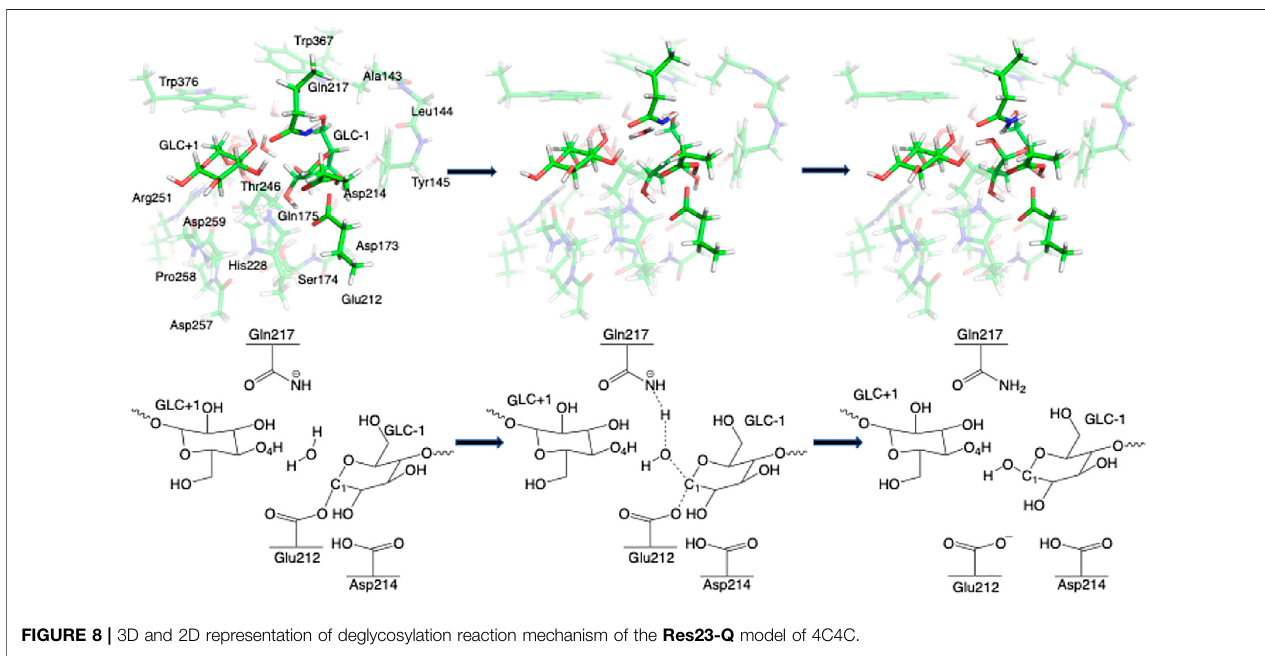
FIGURE 8 | 3D and 2D representation of deglycosylation reaction mechanism of the Res23-Q model of 4C4C.